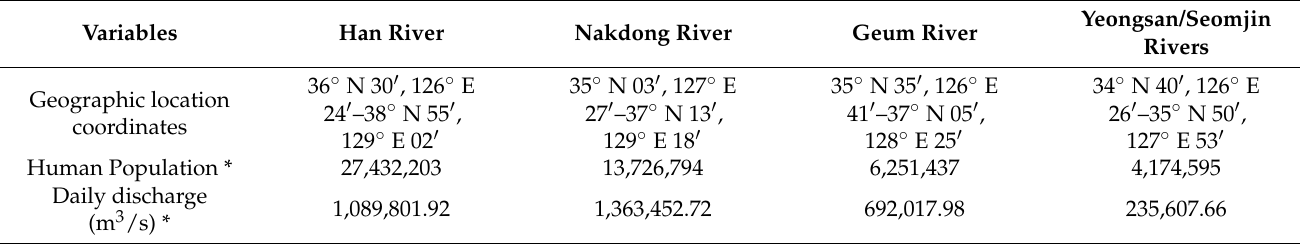
Table 1. Geographic locations coordinates, and demographic and hydrological details of the four major rivers in South Korea.